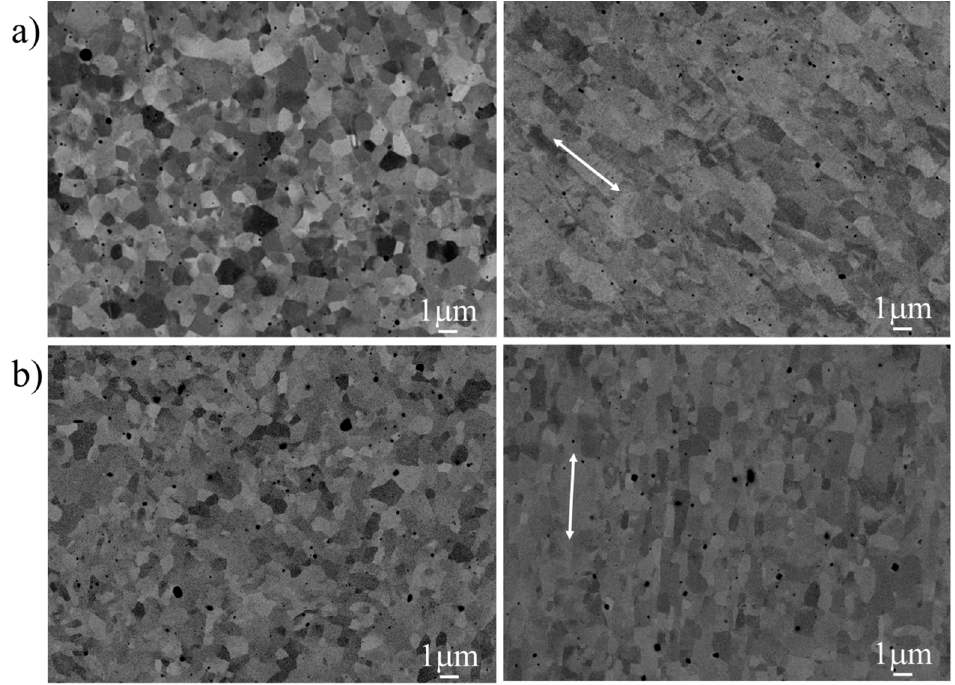
Figure 1. Back ‐ scattered SEM images of the microstructure of ( a ) the transverse short (T–S) plane ( left ) and longitudinal transverse (L–T) plane ( right ) of the PM2000 alloy tube; ( b ) transverse ( left ) and longitudinal ( right ) cross sections of the MA956 alloy bar. The white arrow indicates the L direction. Table 2. Geometric measures of the microstructural characteristics and texture of the PM2000 and MA956 alloys.